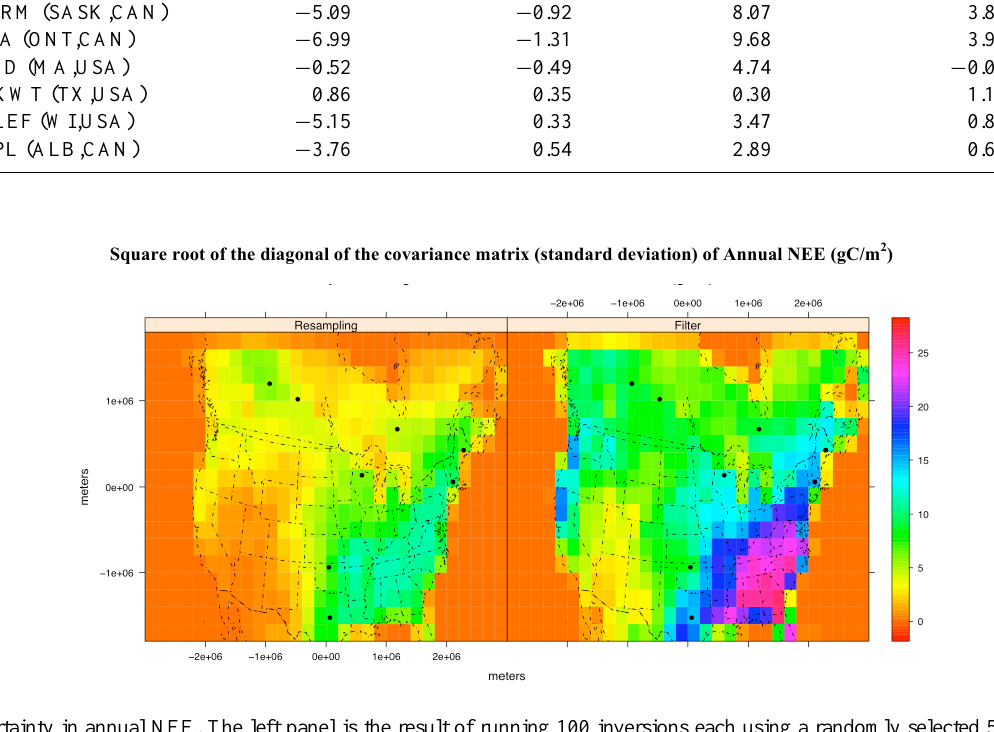
Fig. 4. Uncertainty in annual NEE. The left panel is the result of running 100 inversions each using a randomly selected 50% of the data and then calculating the variance of each cell’s mean estimate, over the 100 inversions, and summing over each of the weekly filter cycles. Finally, the square root of this summed variance (standard deviation) is displayed and is a measure of the uncertainty of the mean estimate due to model over-fitting. For the right panel, the summed annual variance in NEE is calculated for each inversion, from the weekly filter estimates, and the the square root of this (standard deviation) is shown for each cell. These plots aim to provide a measure of the uncertainty of each cell’s NEE estimate, incorporating the correlation between ER and GPP in each cell, but not incorporating the spatial correlation in the covariance matrices.